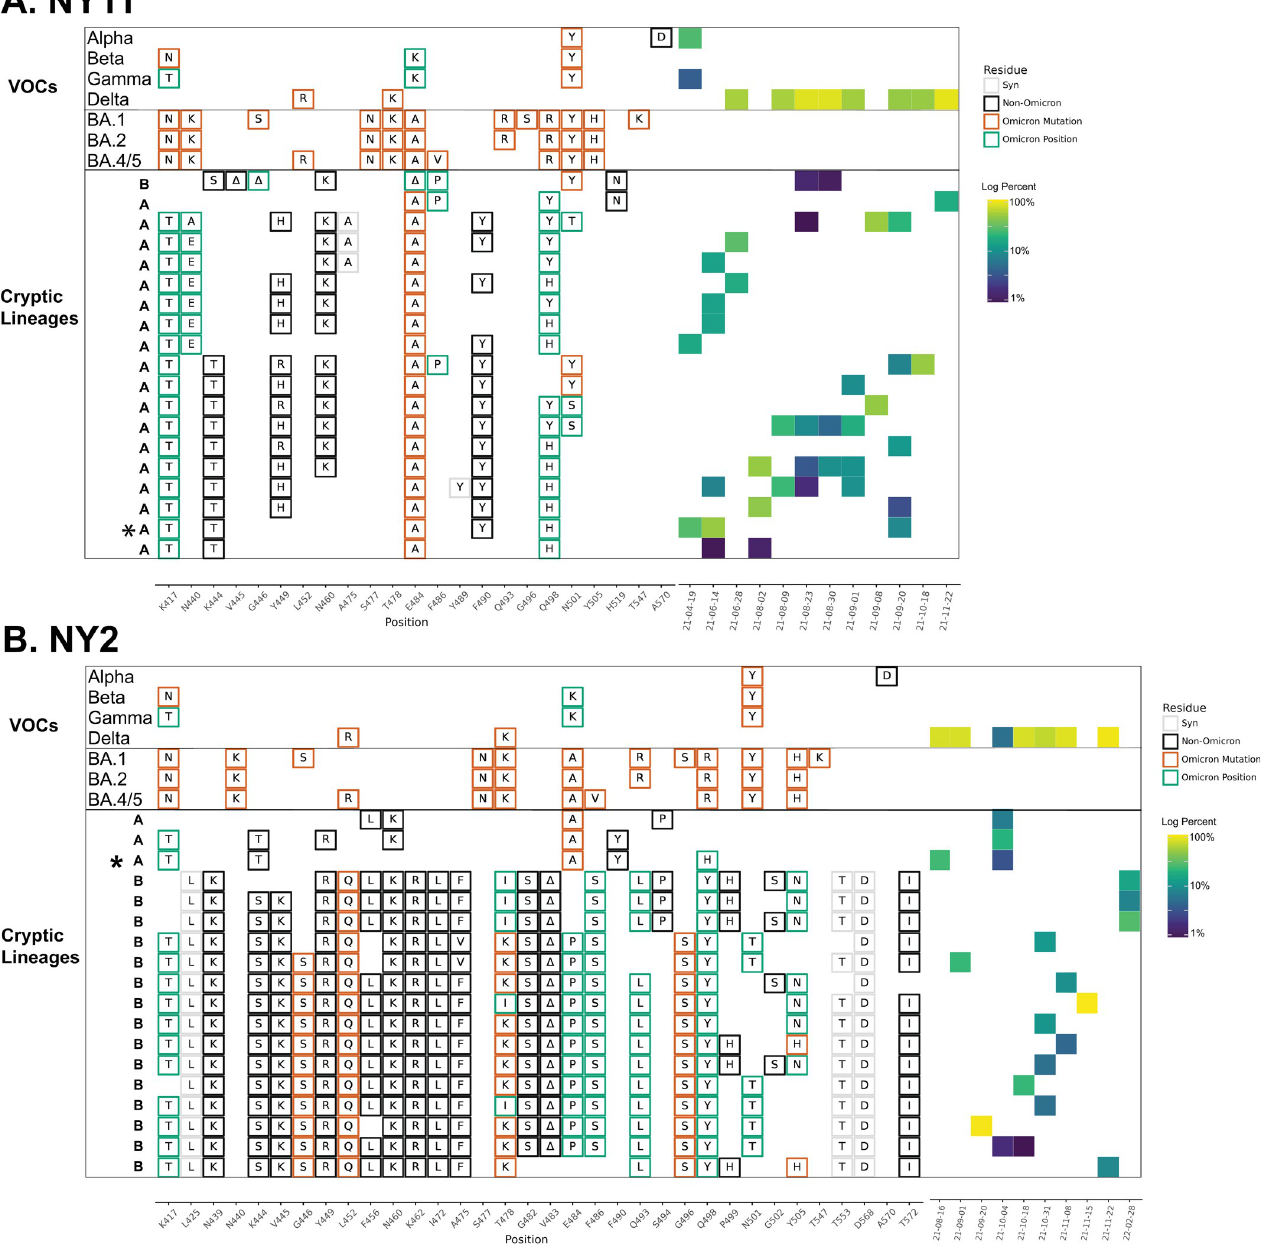
PLOS Pathogens| https://doi.org/10.1371/journal.ppat.1010636 October 14,